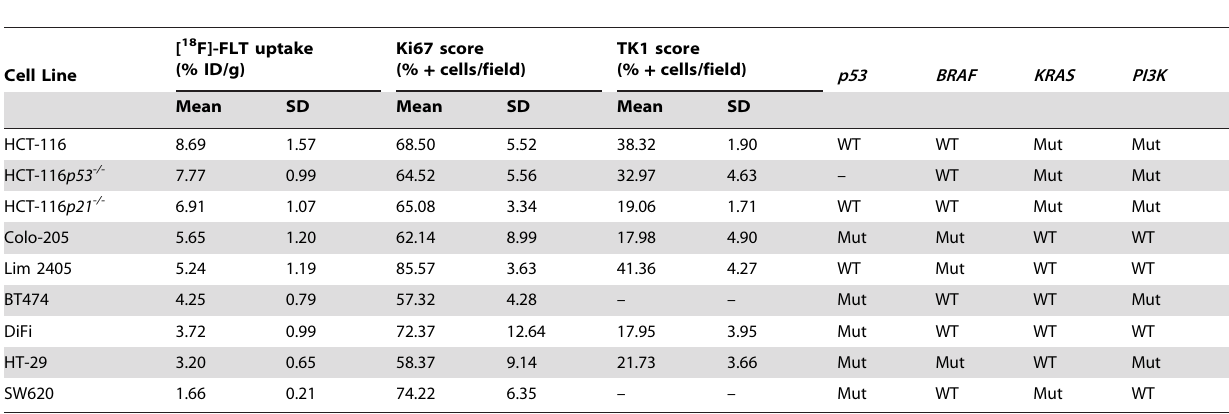
Table 2. Characterization of [ 18 F]-FLT uptake, IHC scoring and tumor mutation status in 8 CRC and one breast cancer cell line